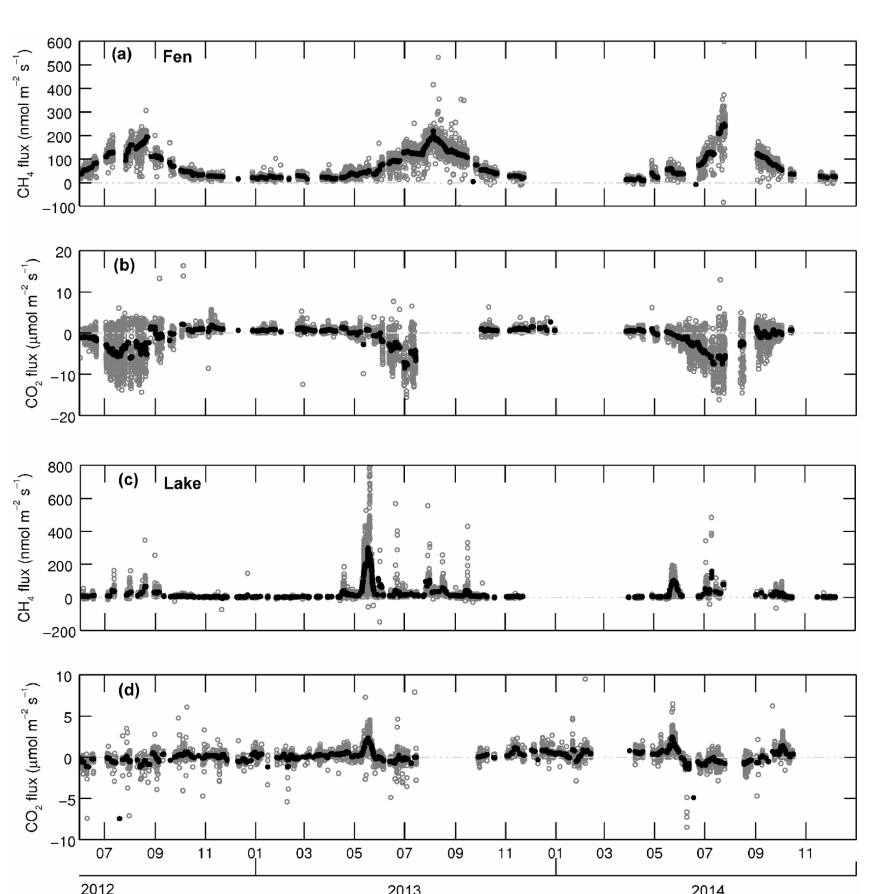
Figure 3. Measured CH 4 and CO 2 fluxes at the fen (a, b) and the lake (c, d) over the full study period. Light grey dots are half-hourly values and black dots show a 5-day running mean. Note on panel (c) : nine flux values above 800nmolm − 2 s − 1 are not displayed for